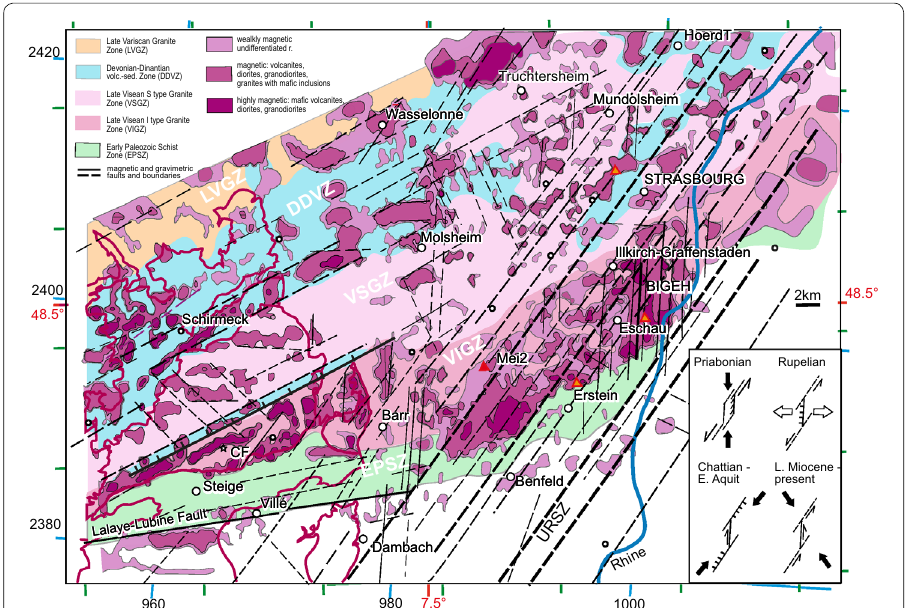
Fig. 9 Interpretative map of the magnetic and gravimetric data with expected basement lithologies, petrographic discontinuities and faults. See details in Fig. 8. URSZ: Upper Rhine shear zone. BIGEH: Bois d’Illkirch-Graffenstaden-Eschau Horst. Inset: schematic tectonic model of the investigated area during Cenozoic times (after Villemin and Bergerat